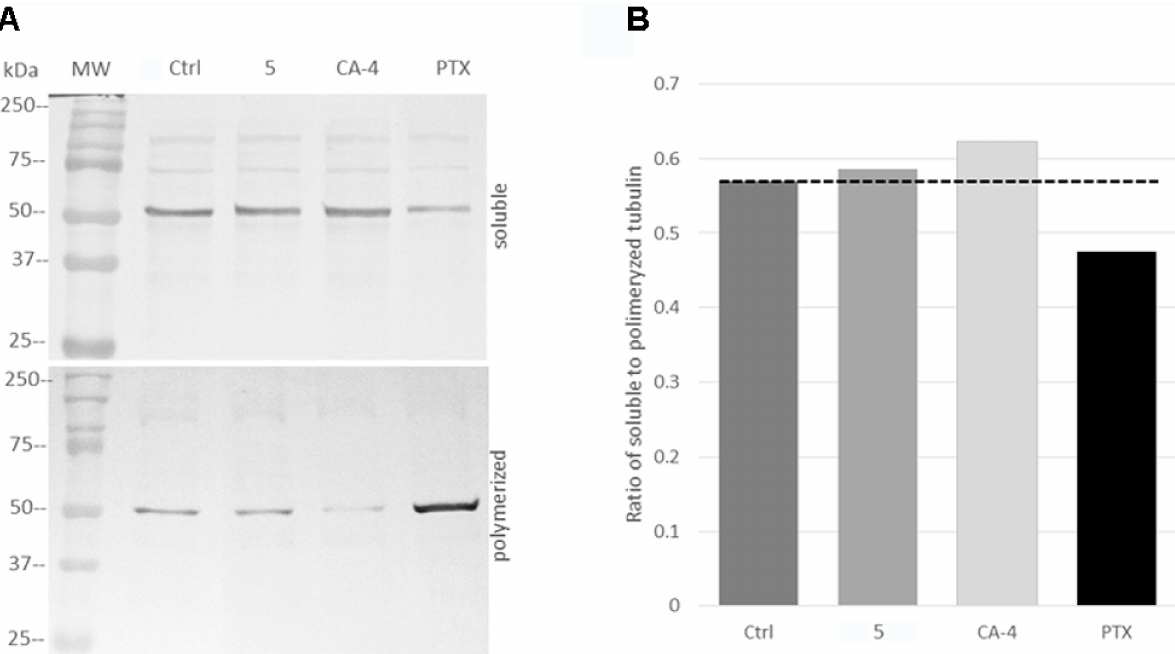
Figure 6. ( A ) Western blot analysis of soluble and polymerized tubulin fractions of cells without treatment (Ctrl) and cells treated with compound 5 (0.16 µ M), CA-4 (1.49 µ M), and PTX (0.08 µ M). ( B ) Ratio of soluble-to-polymerized tubulin of the data A. MW = molecular